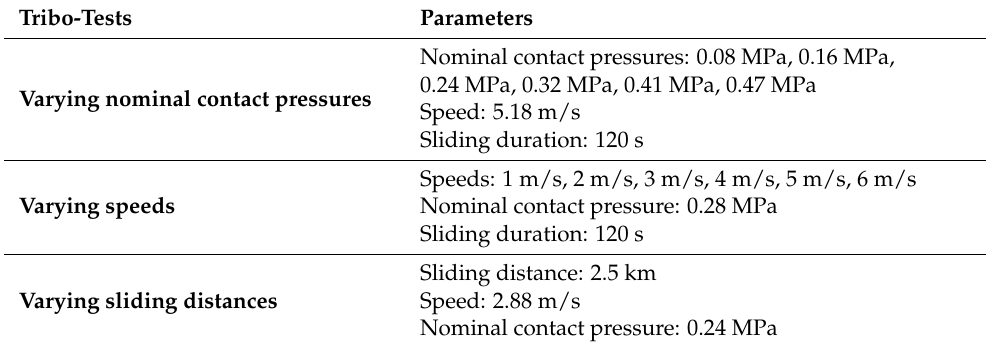
Figure 7. ( a ) Demonstration of test sample cut from the FSPed Workpiece [10] and ( b ) actual image for tribo-test pin. Table 3. Tribo-tests parameters.